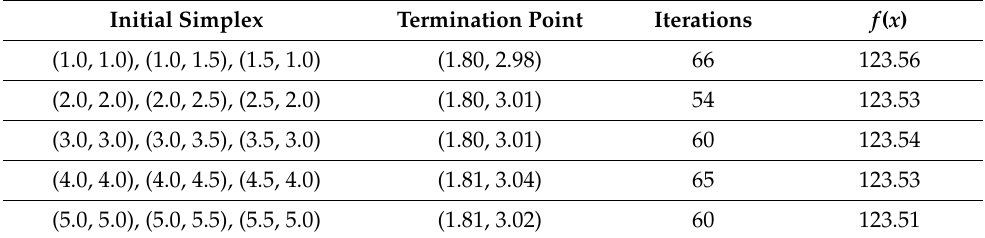
Table 9. Summary of Optimization Results Based on Quadratic